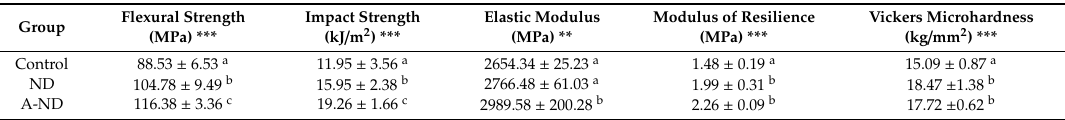
Table 1. Mean values of flexural strength, impact strength, elastic modulus, modulus of resilience and Vickers microhardness of the various groups and their standard